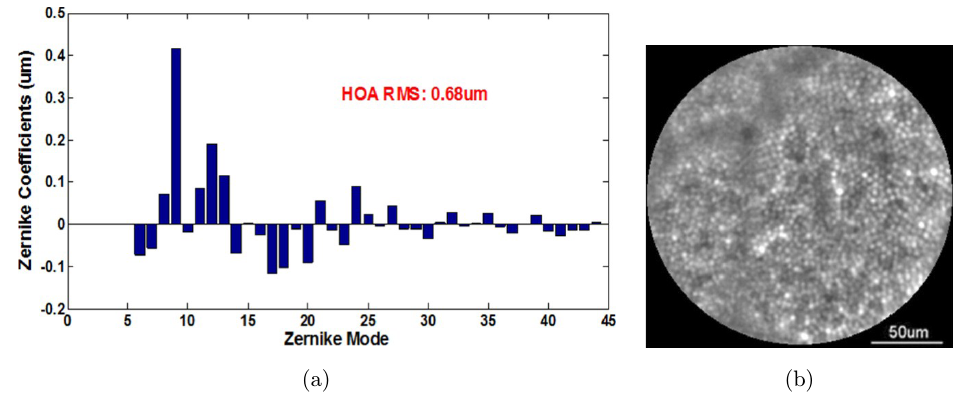
Fig. 10. HOAs of Subject LL (a) and the retinal image with dual DMs correction